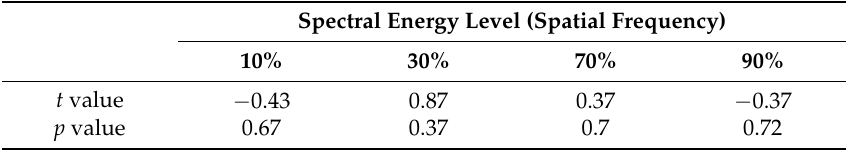
Table A1. Comparison of the spatial frequency information between the Twin Sets (Experiment 1).